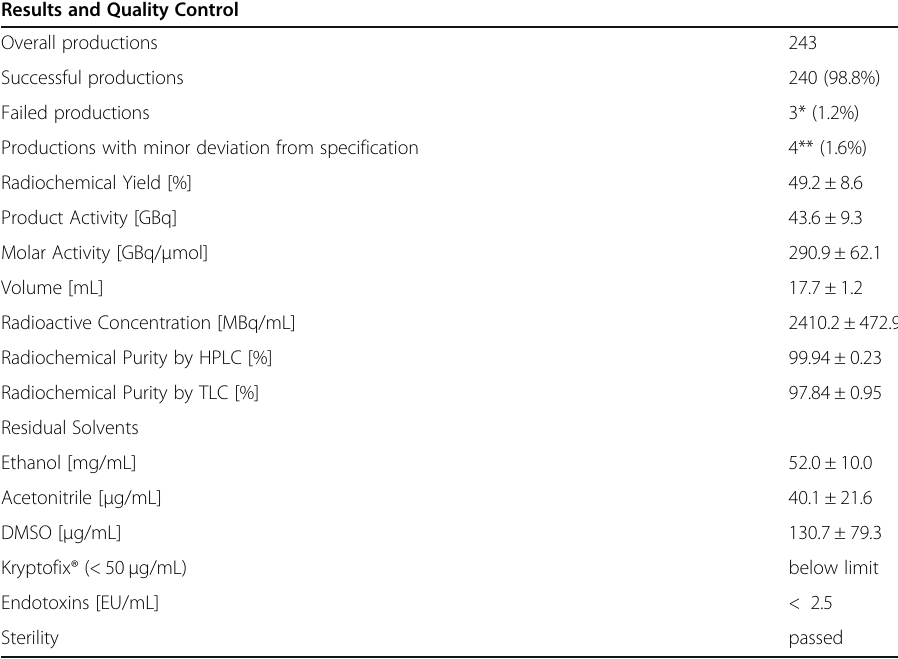
Table 2 Results of the automated clinical productions of [ 18 F]Ga-rhPSMA-7/ -7.3 and corresponding quality control data Results and Quality